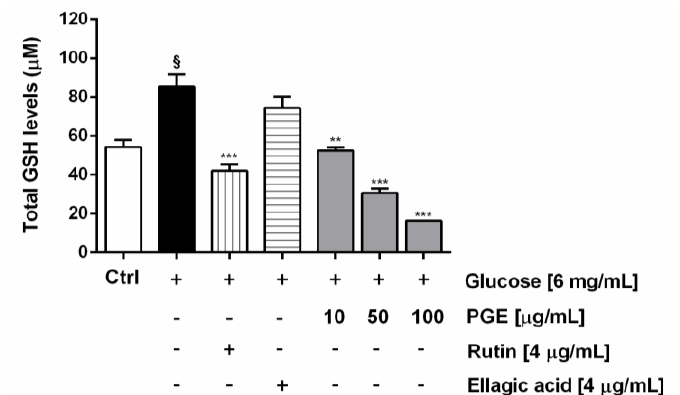
Figure 7. Effect of PGE, rutin, and ellagic acid on total GSH levels induced by hyperglycemia conditions in AGS cells. Total GSH was evaluated in cell lysates and calculated with respect to the calibration curves of GSH and GSSG. Data are mean ± SE from at least two independent biological replicates ( n = 2). § p < 0.01 vs control by Student t -test; ** p < 0.01 and *** p < 0.001 vs Glucose [6 mg/mL ] by ANOVA followed by Dunnett’s Multiple Comparison Post Test.